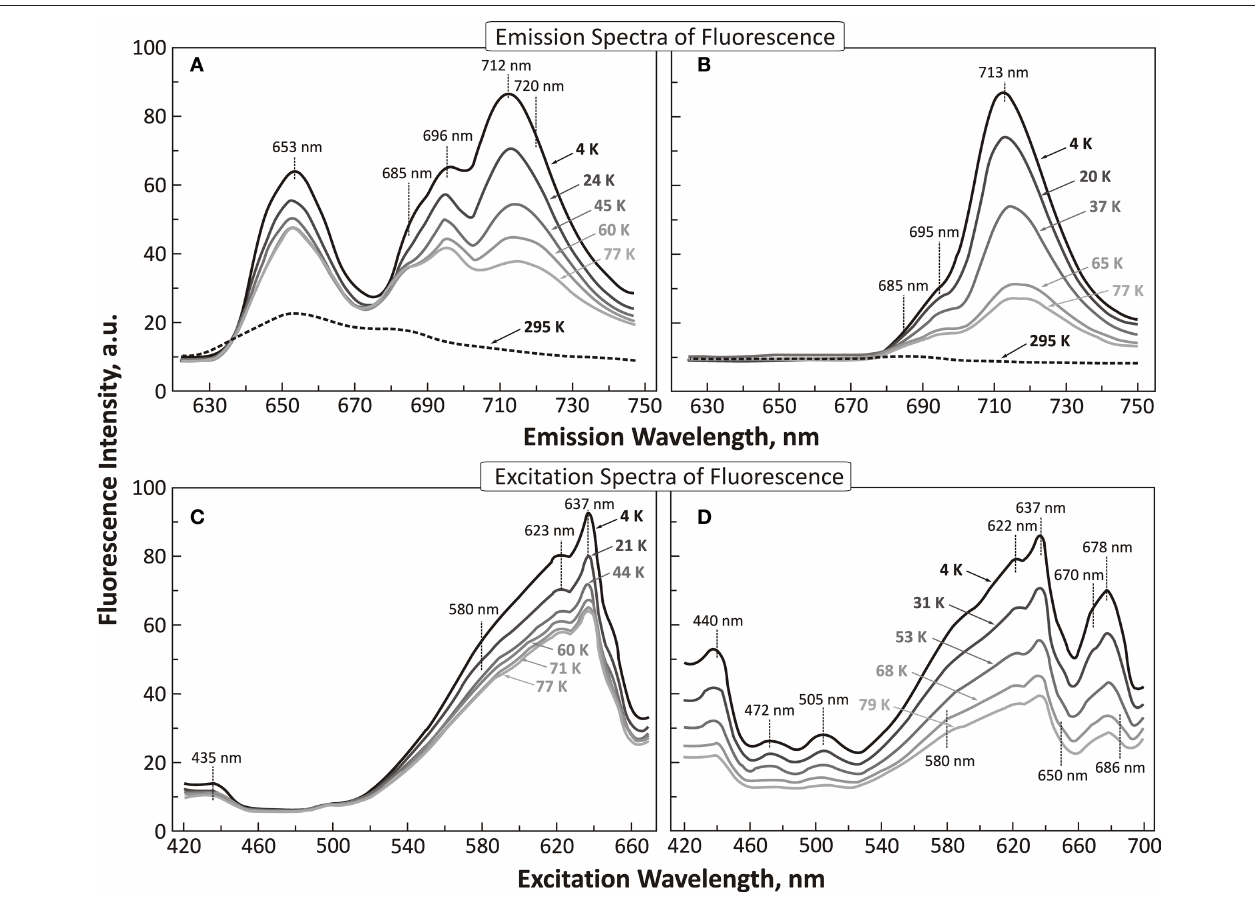
FIgurE 6 | Emission and excitation fluorescence spectra of Anacystis nidulans at low temperatures. (A) Emission spectra of fluorescence in the 4 K (liquid helium temperature) to 77 K (liquid nitrogen temperature) range in cells of A. nidulans ; wavelength of excitation was at 620 nm (absorption by phycocyanin; see Figure 2B ). For comparison, a room temperature (295 K) spectrum (black dashed curve) is shown. (B) Emission spectra of fluorescence in the 4–77 K range in cells of A. nidulans ; wavelength of excitation was at 440 nm (absorption